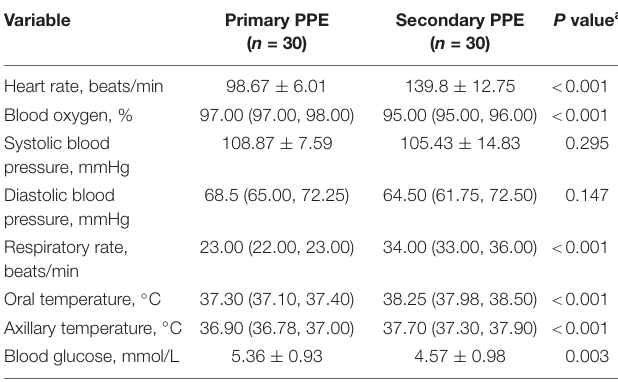
from 2 to 5 pm. This study used brisk walking (1.0 m/s) TABLE 1 | The analysis of physical indicators of participants between primary personal protective equipment (PPE) and secondary PPE after trial.